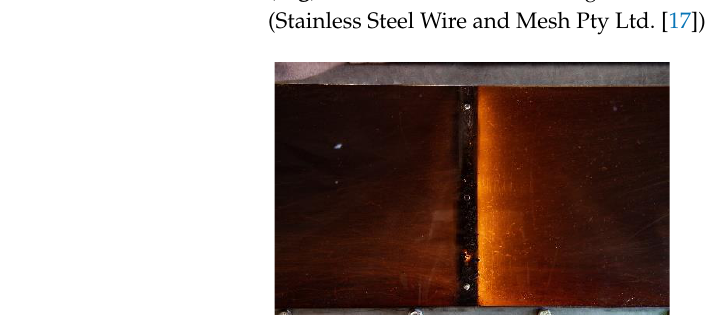
Figure 15. Wandering of small firebrands at the exit side of the mesh in consecutive frames of ( a – g ) shows the end of wandering and movement in wind direction, ( h ) shows the firebrand quenched (Stainless Steel Wire and Mesh Pty Ltd. [17]).